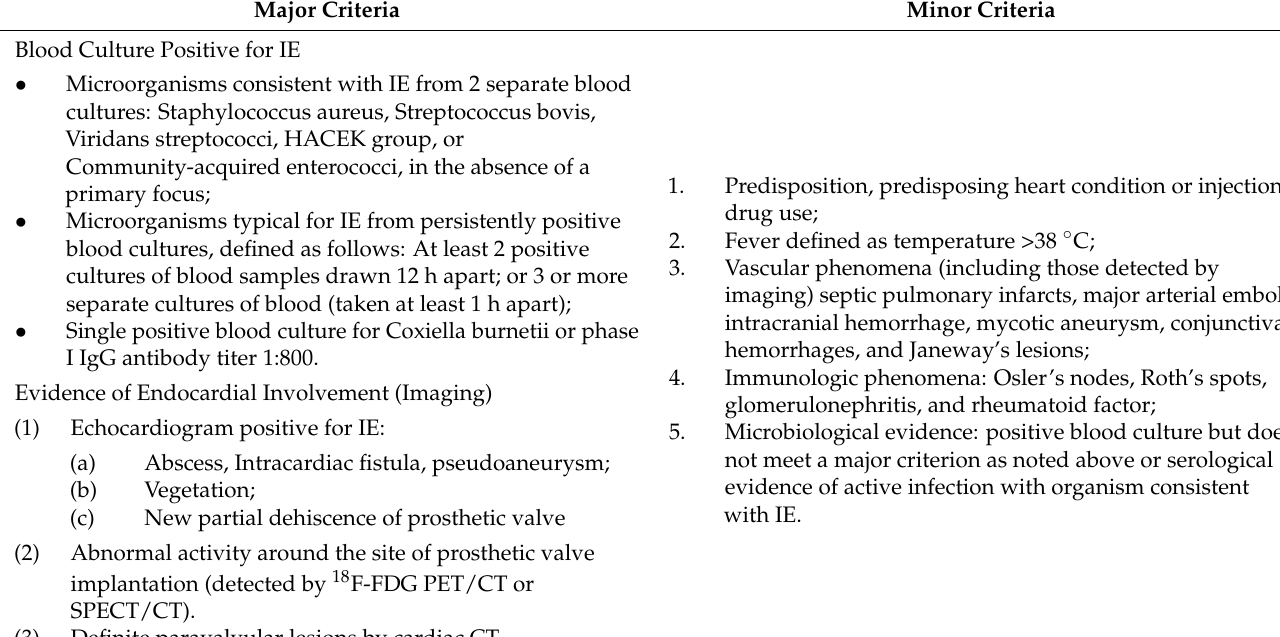
Table 1. Modified DUKE criteria for diagnosis of IE (in bold the modifications as per 2015 ESC guidelines).